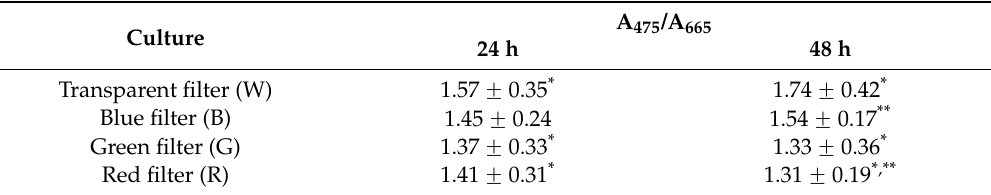
Table 2. The ratio of the absorbance at 475 nm to the absorbance at 665 nm for the methanolic extract of the cultures grown under the different filters. White light exposure was ca . 65 µ mol quanta m ´ 2 s ´ 1 . Values significantly differ between the 24 h or 48 h growth period and are indicated by the same superscript (*, **). *, W ‰ G and R; and **, B ‰